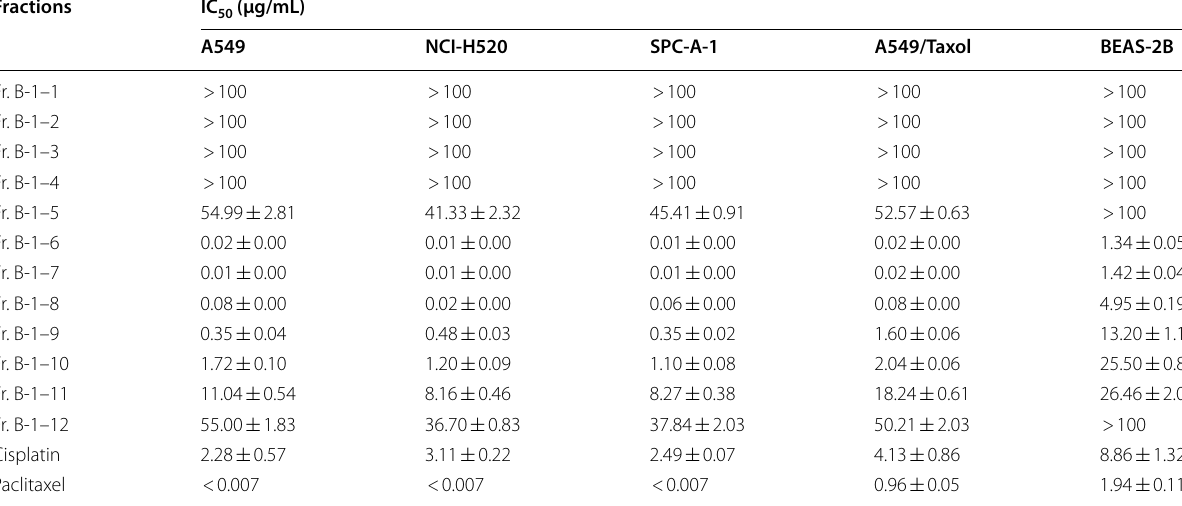
Table 4 Cytotoxicity of the subfractions from the active fraction (Fr. B‑1) against the A549, NCI‑H520, SPC‑A‑1, A549/Taxol, and BEAS‑2B cell lines